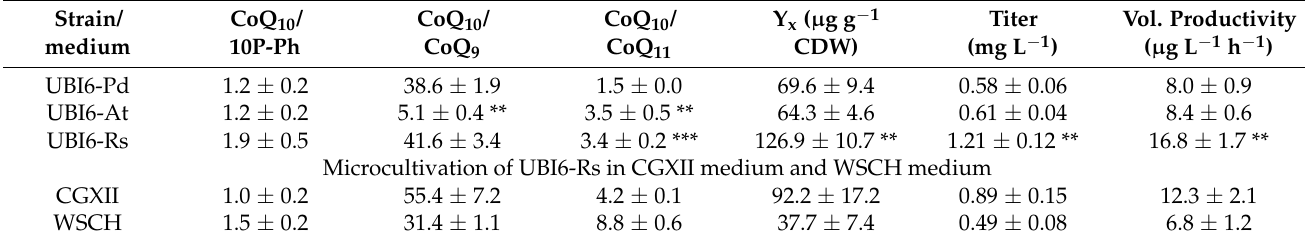
Table 3. Ratios of relative peak areas from mass spectrometry analysis and CoQ 10 biomass yields, titers, and volumetric productivities for the strains UBI6-Pd, UBI6-At, and UBI6-Rs. In addition, UBI6-Rs was cultivated in a BioLector microcultivation system in CGXII medium (same as before) and WSCH medium.